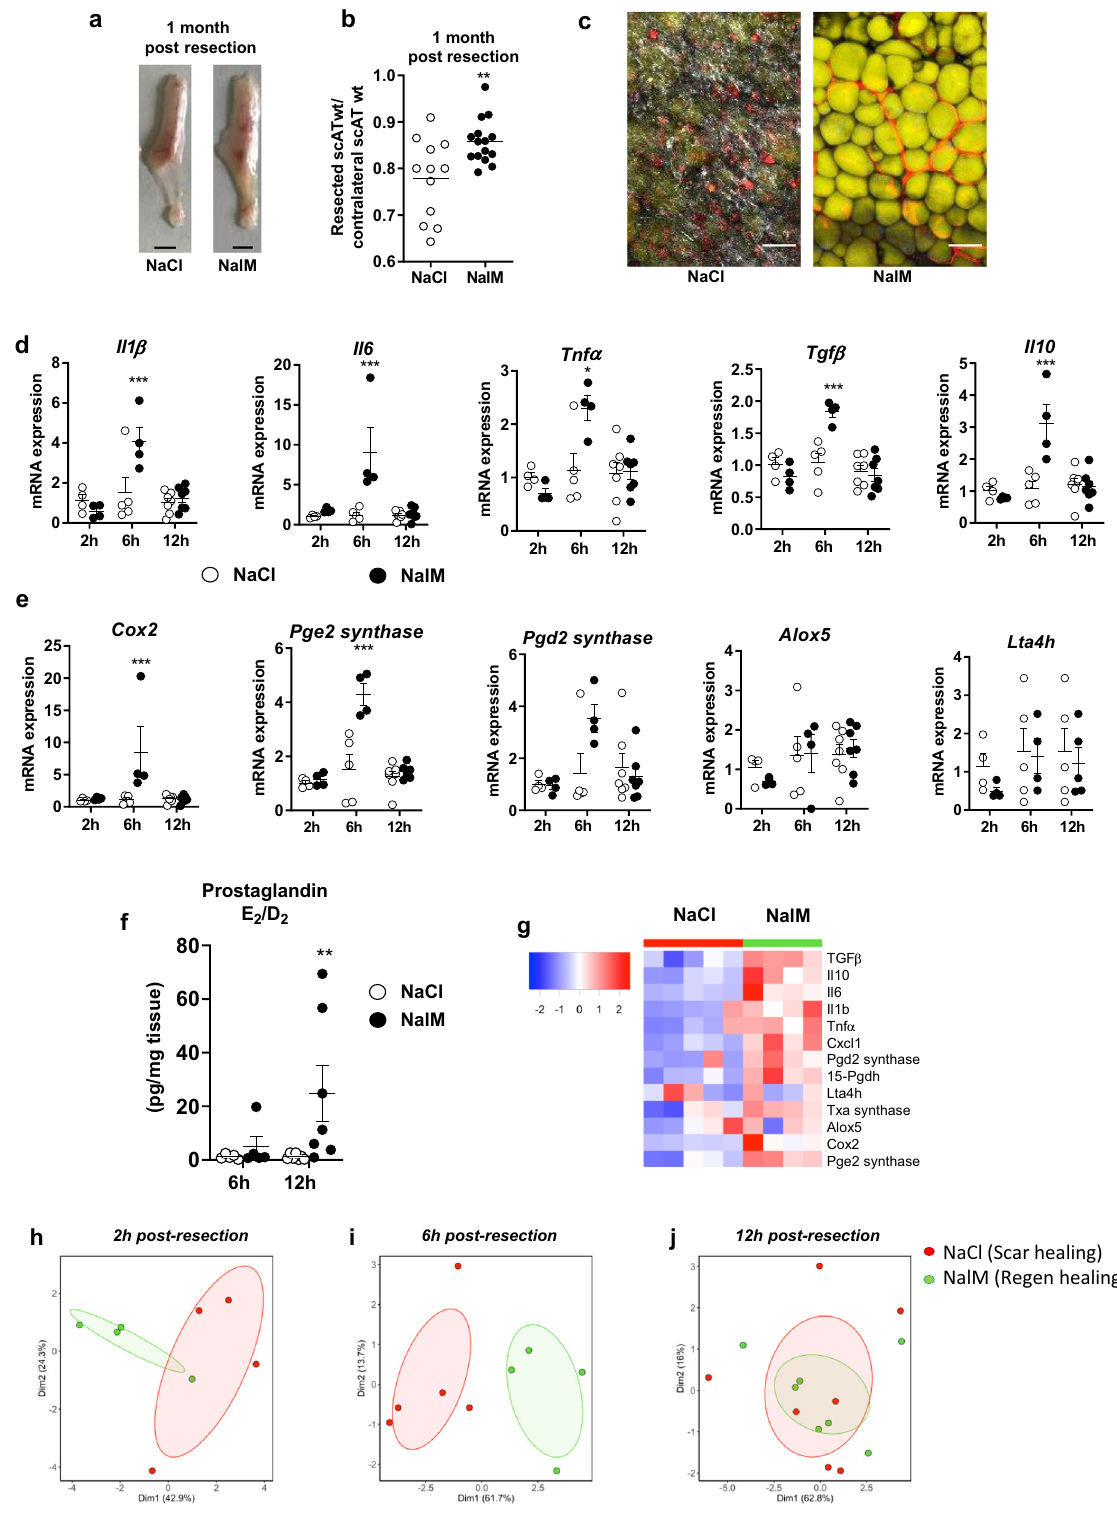
being similar in µKO and NalM-treated mice and signi fi cantly higher than in NaCl-treated mice (Fig. 2j). Altogether, these results demonstrate that through a direct effect on µ opioid receptors, NalM-induced ROS production by granulocytes determines tissue repair